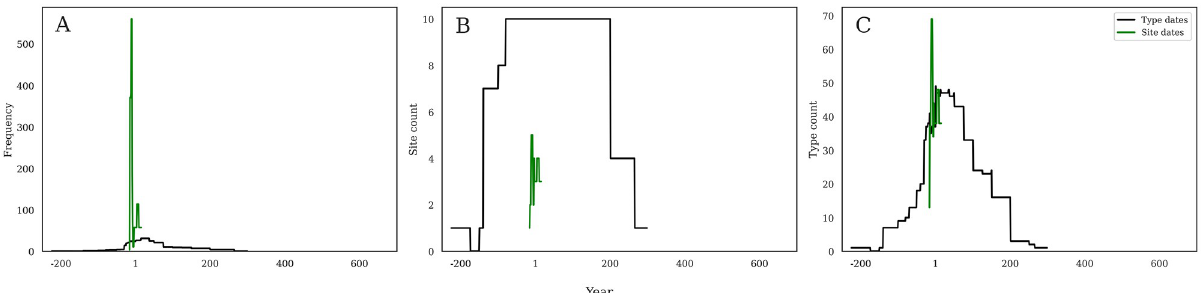
Fig 11. a-c. Augustan-period sites. Comparison of Augustan-period sites across three different methods of analysis according to production dates (black) and consumption dates (green). Note that Y axes are not constant.